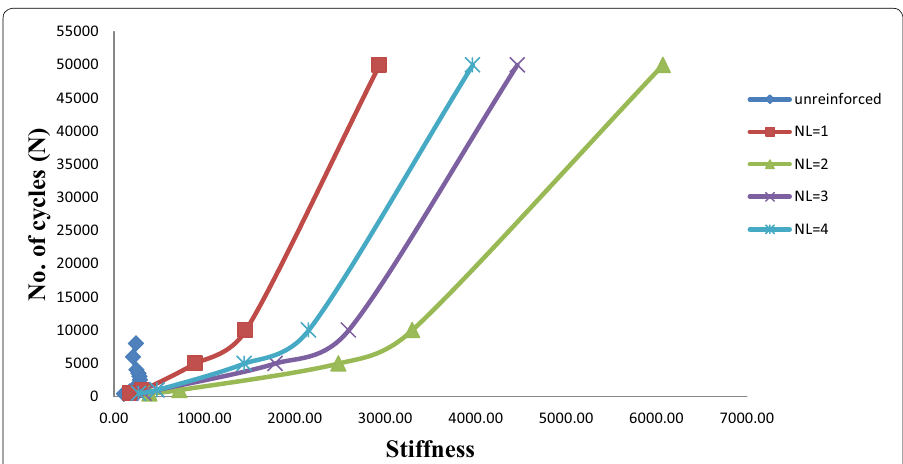
Fig. 10 Stiffness with no. of cycles for different layer configuration under F